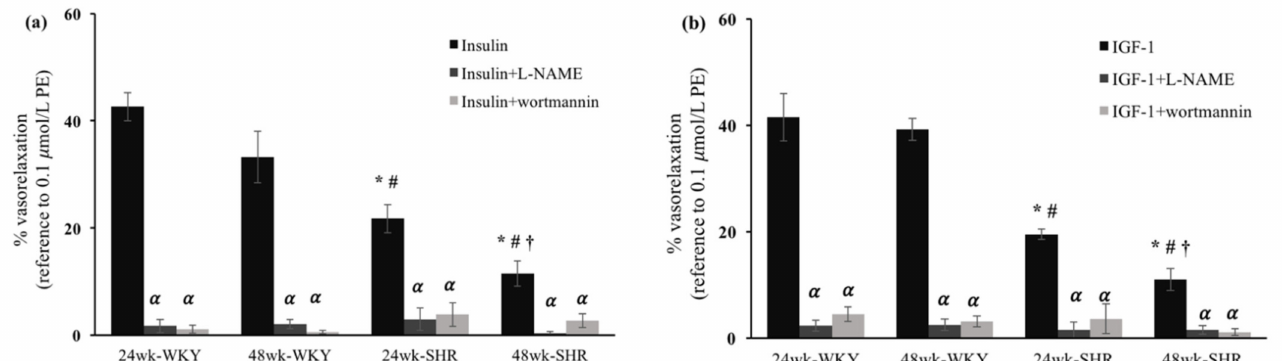
Figure 3. Vasorelaxation after the pretreatment of nitro-L-arginine methyl ester (L-NAME) and wortmannin. ( a ) Insulin (10 − 6 mol/L)-mediated vasorelaxation and ( b ) IGF-1 (3 × 10 − 8 mol/L)-mediated vasorelaxation after the pretreatment of L-NAME and wortmannin in the 24wk-WKY, 48wk-WKY, 24wk-SHR, and 48wk-SHR groups. The vasorelaxing responses were expressed as the percentages of the 0.1 µ mol/L PE-induced precontractile force. Abbreviation: PE, phenylephrine. * p < 0.05, significant differences from 24wk-WKY; # p < 0.05, significant differences from 48wk-WKY; † p < 0.05, significant differences from 24wk-SHR; α p < 0.05, significant differences from no inhibitors; n = 8 in each